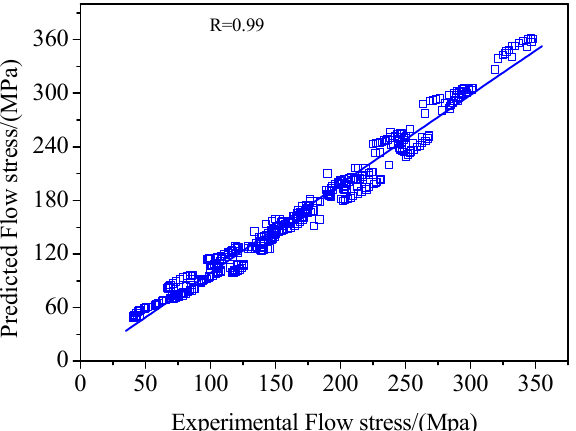
Figure 7. Correlation between the predicted and experimental flow stresses for the strain range of 0.05–0.9 (at intervals of 0.05) over the entire strain rate (0.01–10 s − 1 ) and deformation temperature range (900–1150 ◦